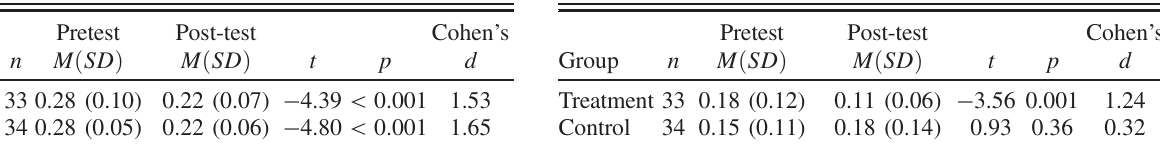
TABLE III. Results of the paired-sample t tests for confidence judgments of conceptual understanding.